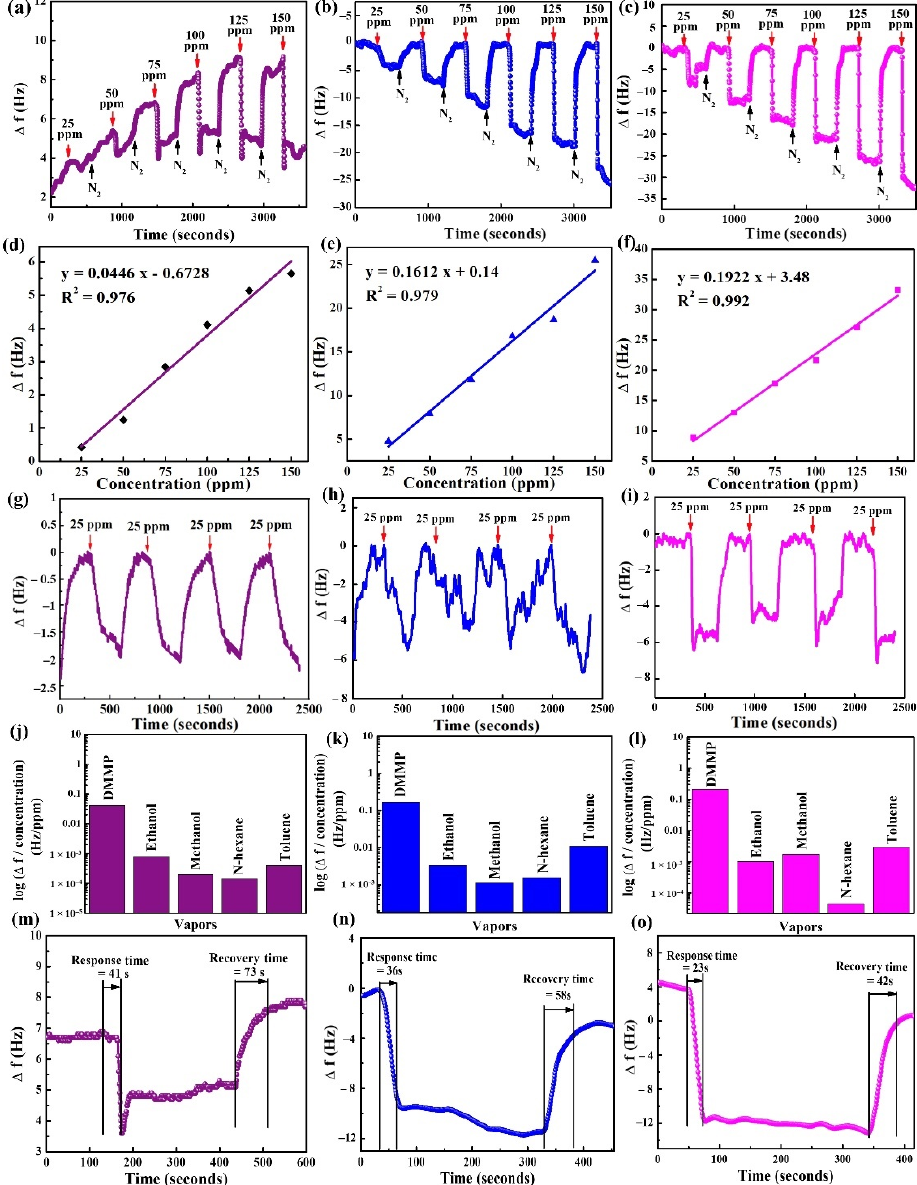
Figure 11. Frequency shifts of ( a ) CE, ( b ) MnO 2 @CE, ( c ) MnO 2 @CE/PPy; linearity of ( d ) CE, ( e ) MnO 2 @CE, ( f ) MnO 2 @CE/PPy; Repeatability of ( g ) CE, ( h ) MnO 2 @CE, ( i ) MnO 2 @CE/PPy, for 25 ppm DMMP; selectivity of ( j ) CE, ( k ) MnO 2 @CE, ( l ) MnO 2 @CE/PPy; and response/recovery times of ( m ) CE, ( n ) MnO 2 @CE, ( o ) MnO 2 @CE/PPy, for 75 ppm DMMP vapor; in the QCM